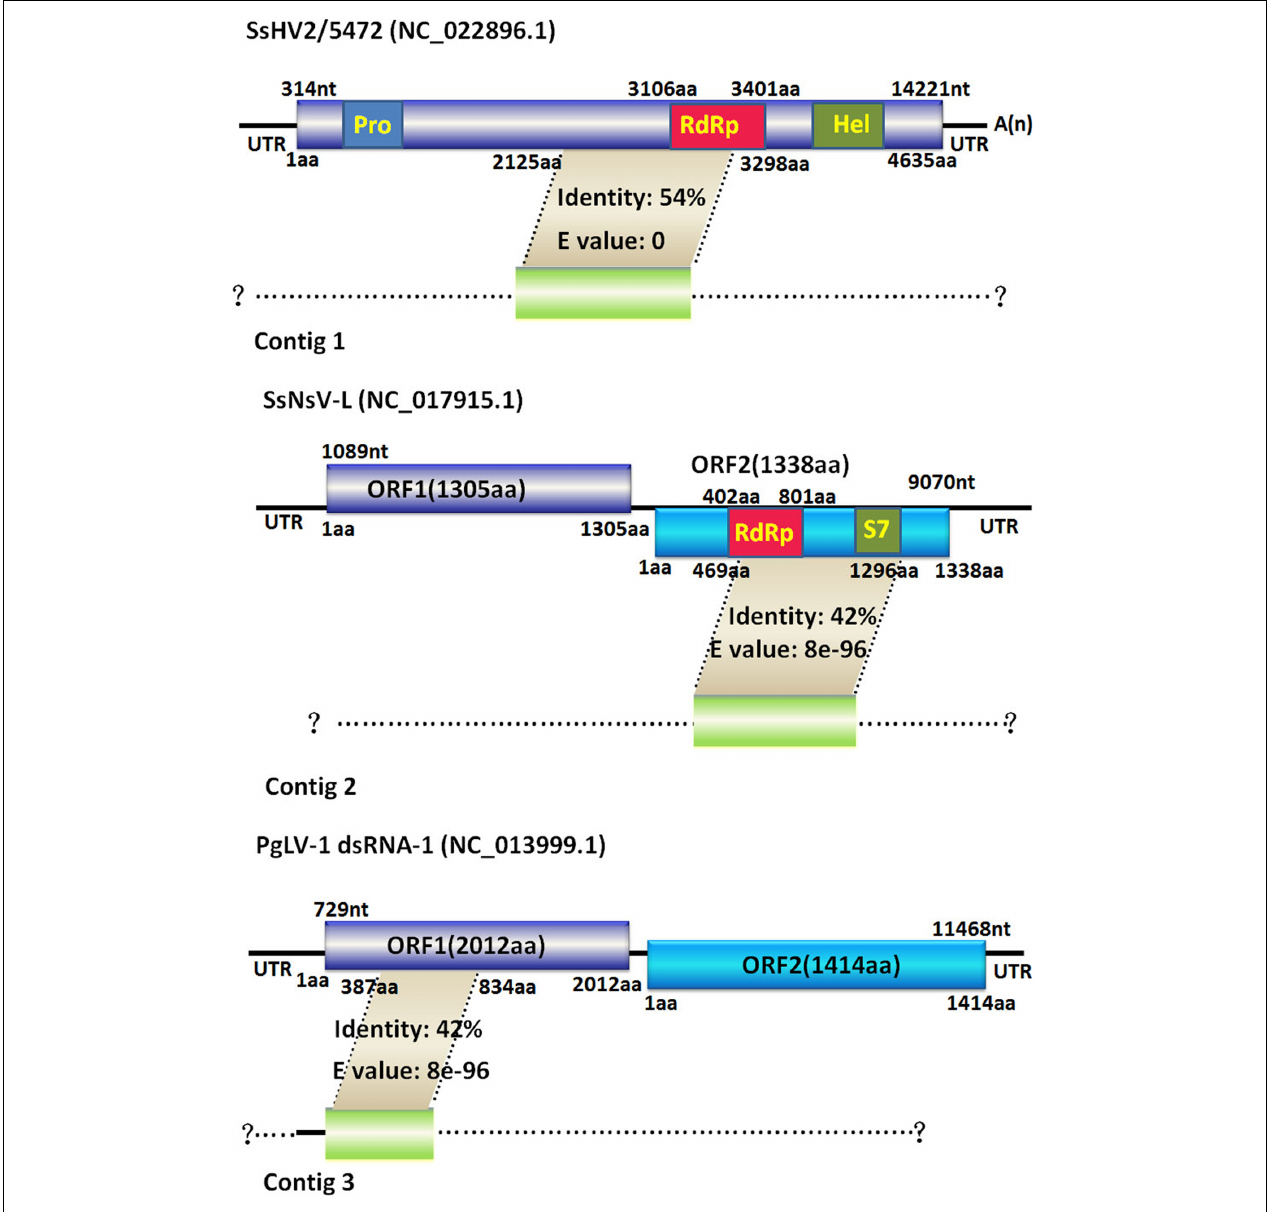
FIGURE 10 | Genomic organization of the three contigs and their comparison with each similar reported mycovirus. Contigs 1, 2, and 3 are schematically represented in the (top, middle, and lower panel), respectively. Contigs 1, 2, and 3 have maximum amino acid sequence similarities to SsHV2/5472, SsNsV-L and PgLV-1 dsRNA1, respectively. The dashed lines indicate the possible undetermined sequences of the three contigs’ corresponding viruses. The colored boxes and lines represent ORFs and non-coding sequences (UTR), respectively. The smaller boxes in the SsHV2/5472 ORF and the SsNsV-L ORF2 showed conserved domains, such as Pro, RdRp, Hel and S7. The nt and aa numbers above the boxes indicate the map positions corresponding to their genomic structure. The gray areas between the three contigs and their respective most closely related mycoviruses denote the homologous regions with similarities to the translated amino acid sequences of the three